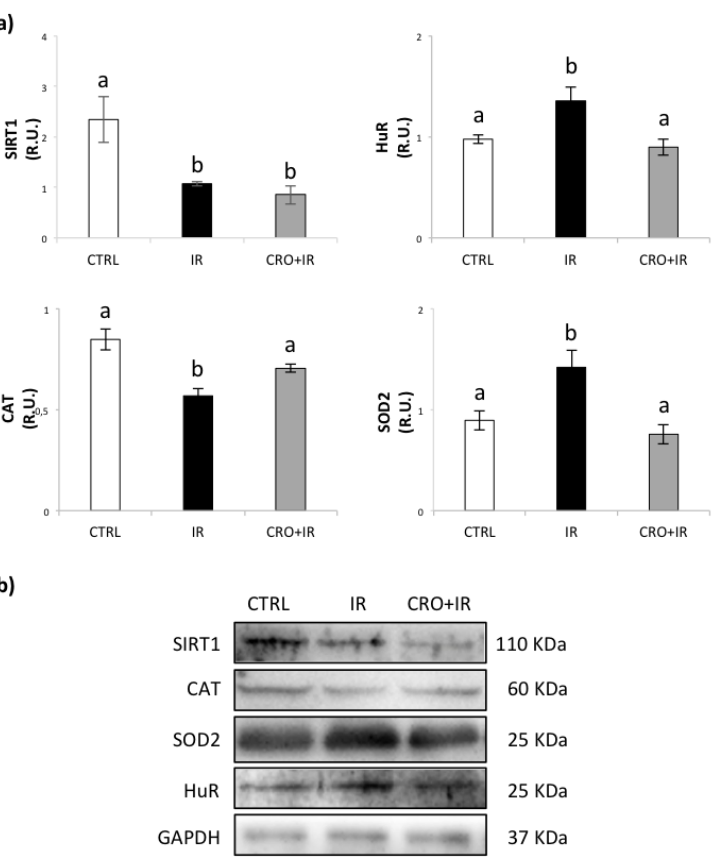
Figure 3. ( a ) Western blot analysis of SIRT1, HuR, CAT, and SOD2 protein levels. ( b ) Representative images of immunoreactive bands. Data are presented as means ± SEM of densitometric analysis of immunoreactive bands normalized to internal reference protein (GAPDH). One-way ANOVA p < 0.05; a,b p < 0.05, Holm–Sidak post hoc multiple comparison. To evaluate the role of autophagy, we analysed the proteins implicated in this process. Our data showed that IR significantly decreased the content of p62 and raised LC3-II in mice testes compared with control as an evidence of increased autophagy. Crocetin pretreatment was not capable to restore the basal levels of p62 and LC3-II and so to prevent the autophagic activation (Figure